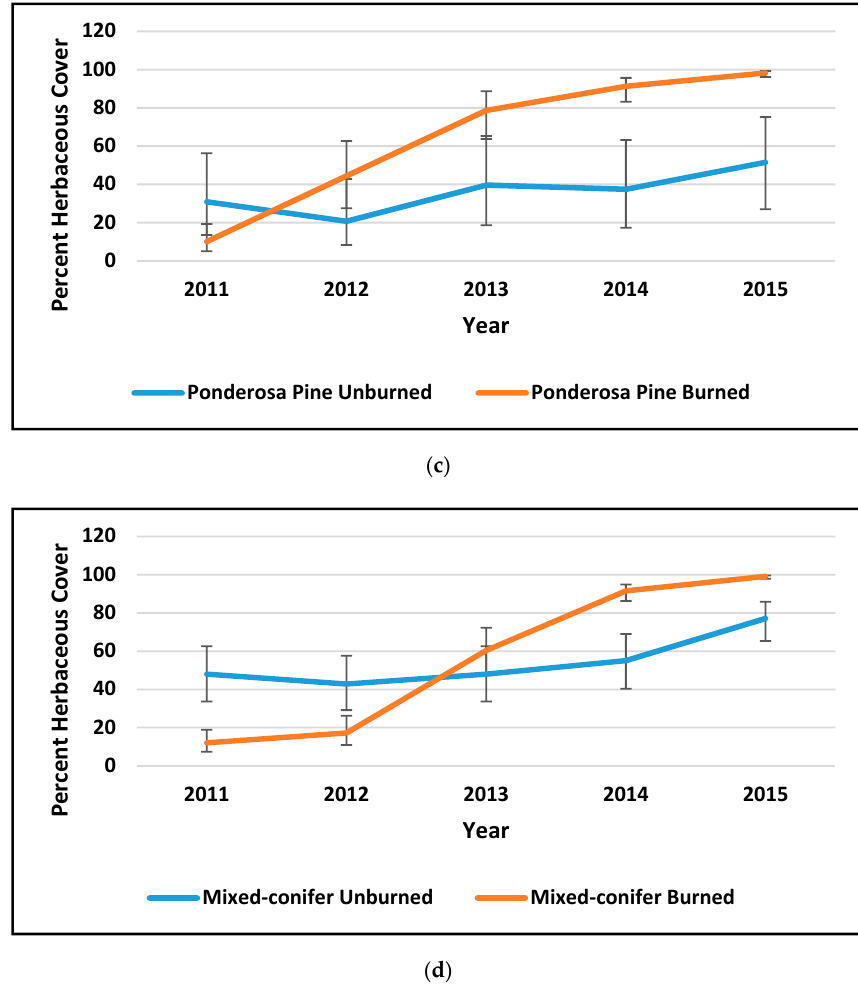
Figure 2. Percent cover by year of exposed litter ( a , b ) and percent herbaceous cover ( c , d ) in ponderosa pine forest (PP) and mixed-conifer forest (MC) at the Valles Caldera (data courtesy Caldera staff). Error bars are 95% confidence intervals. Vegetation cover in Mountain Valley Grassland was always between 90% and 100%; see Suazo et al. (2018) for more detail.